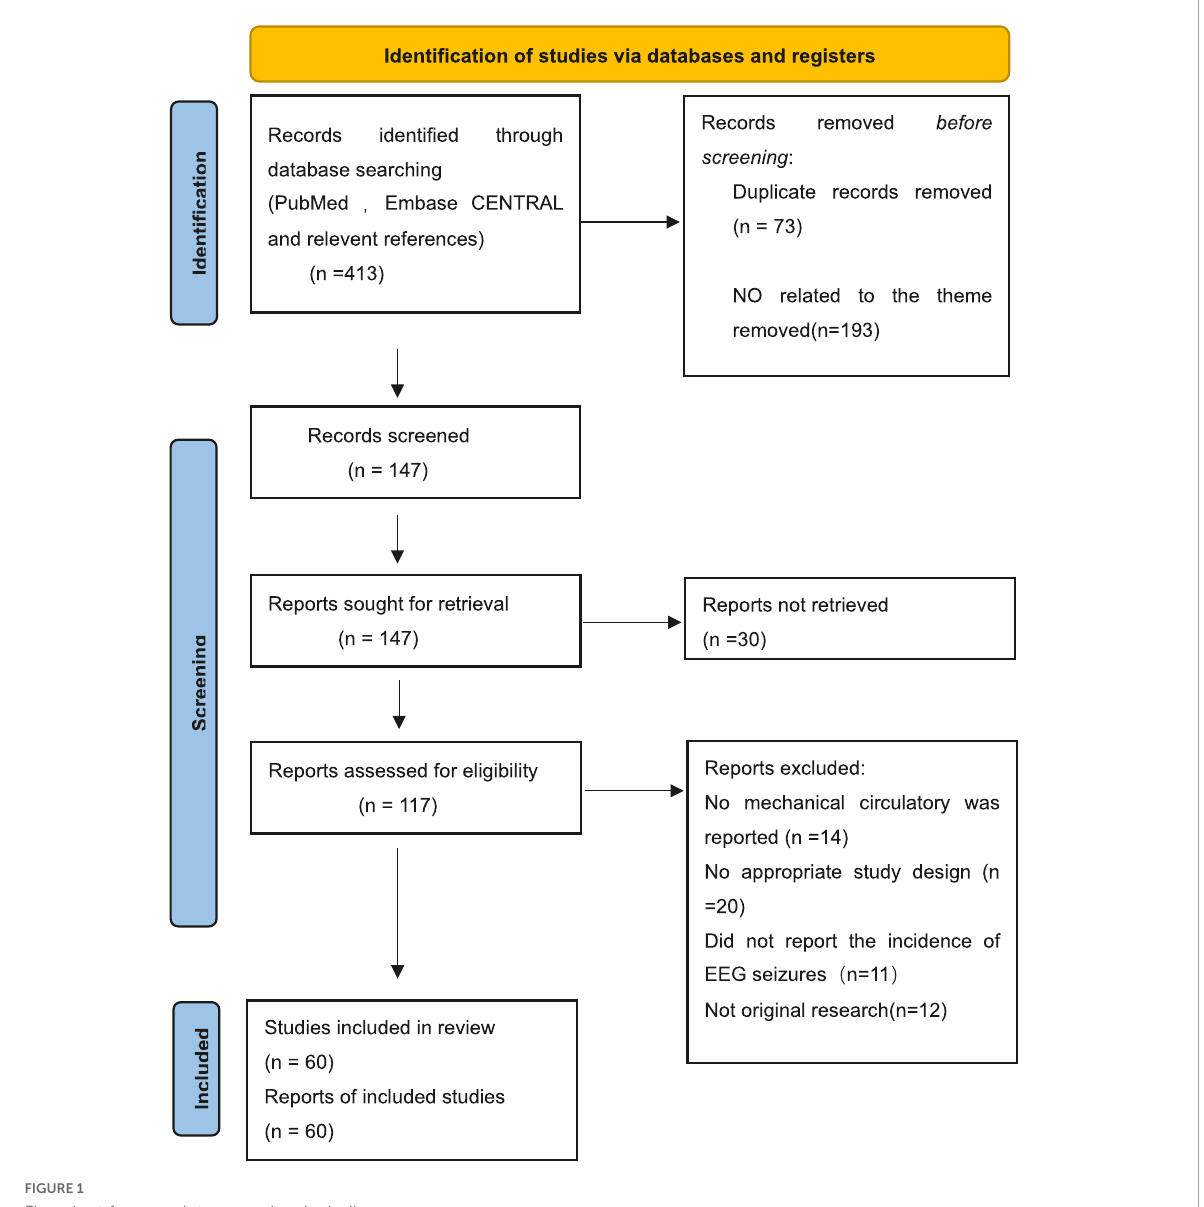
FIGURE1 Flowchart for complete screening, including